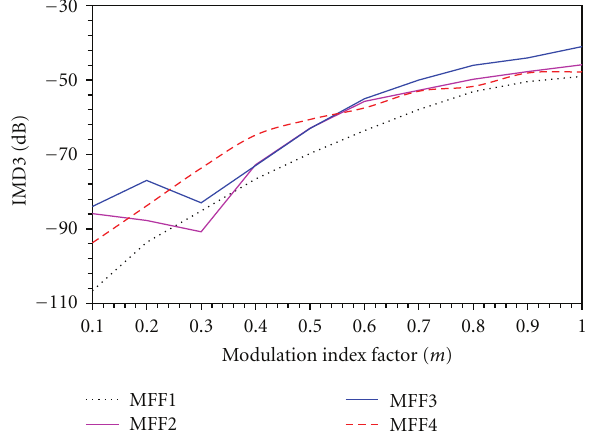
Figure 9: Linear performance of the LP filter functions of 5th order log-domain MFFs of Figure